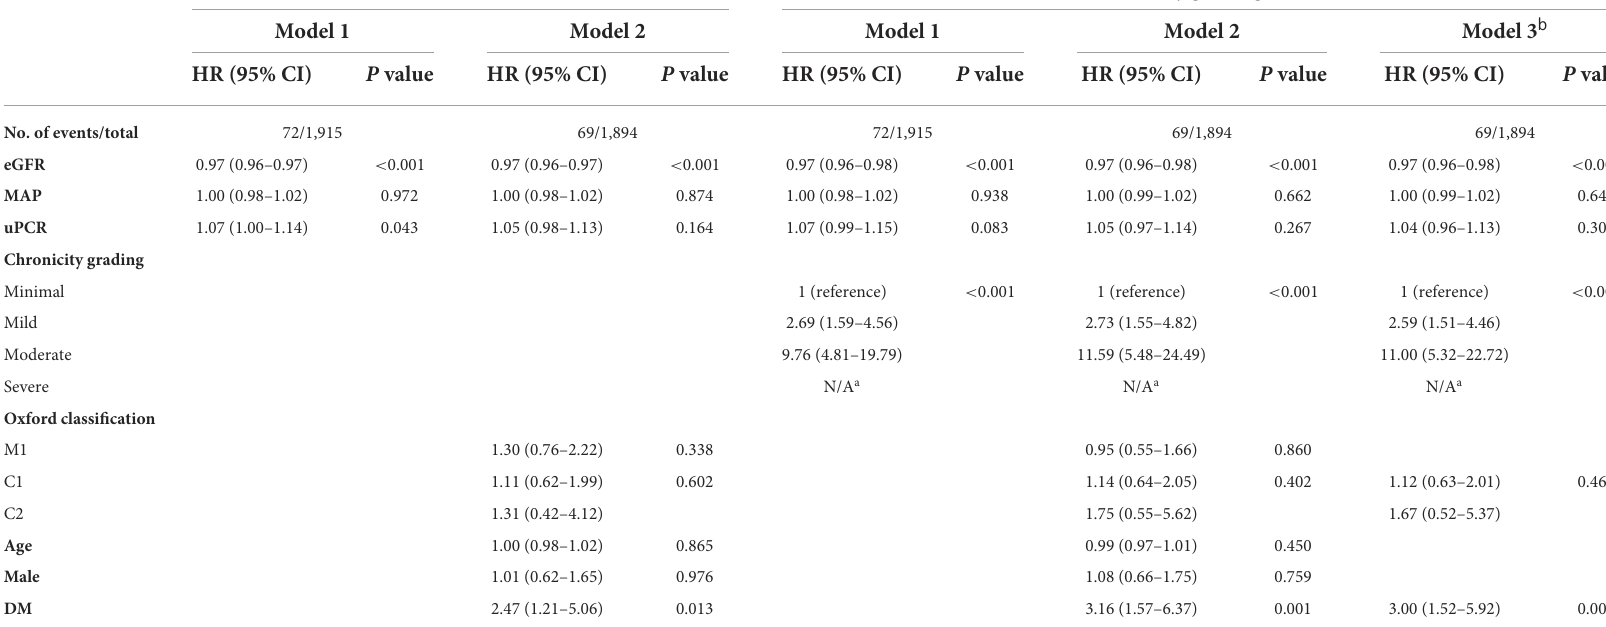
TABLE 9 Association of chronicity grading and Oxford classification with ESRD progression in patients with both Oxford S0 and